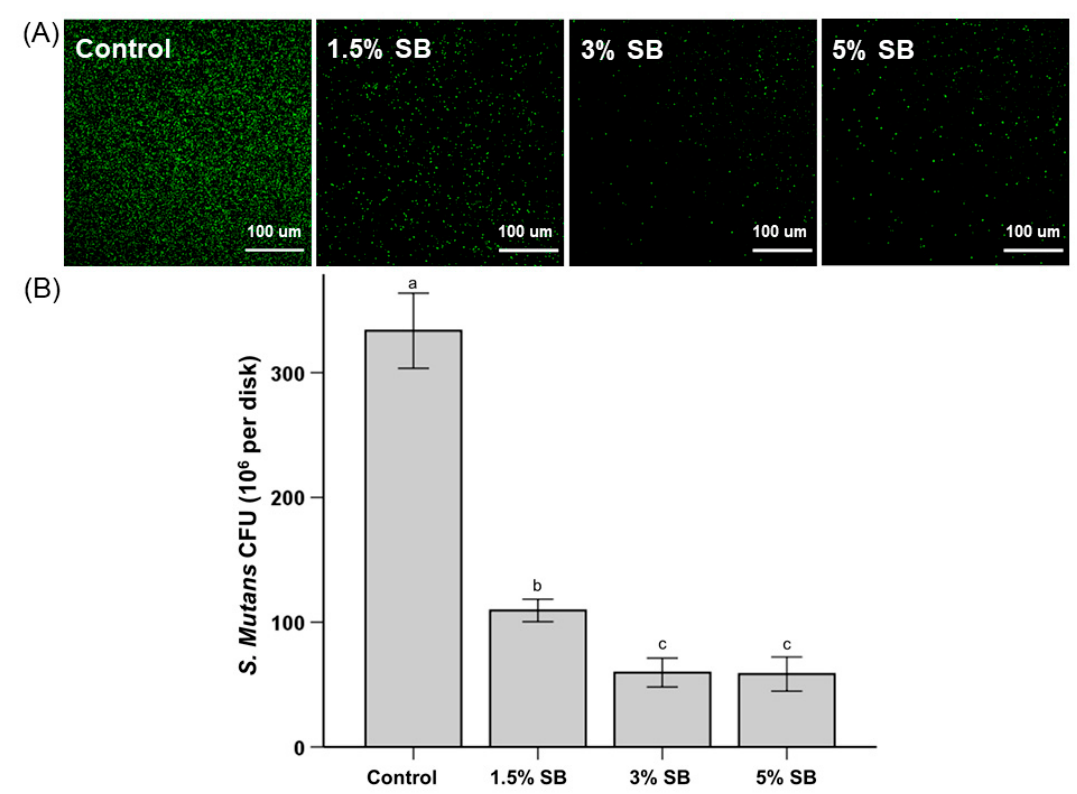
Figure 3. Representative live/dead staining images of bacteria ( S. mutans ) attached on the surfaces of a control sample and samples of SB-modified sealants with varying wt% of SB ( A ). Colony-forming unit (CFU) counts of S. mutans attached on the surfaces with different concentrations of SB ( B ). The different lowercase alphabetical letters above the bars indicate significant differences.